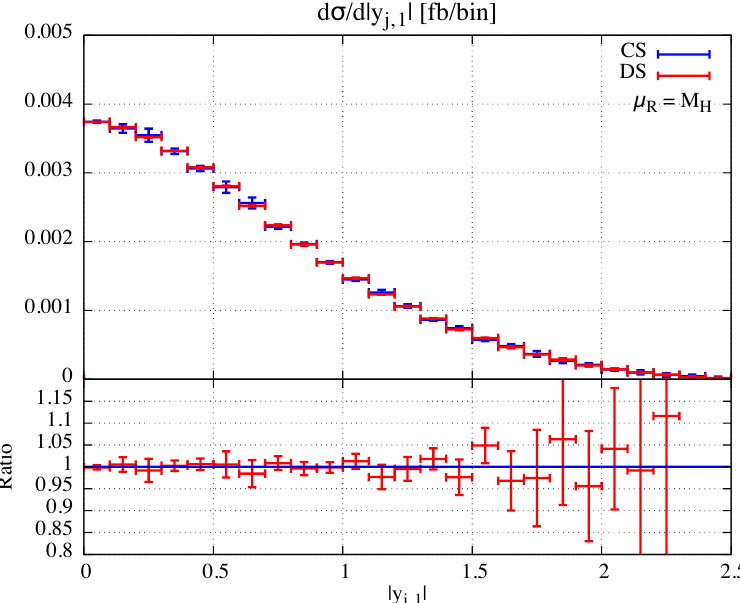
¯ b at NLO. (Durham algorithm,